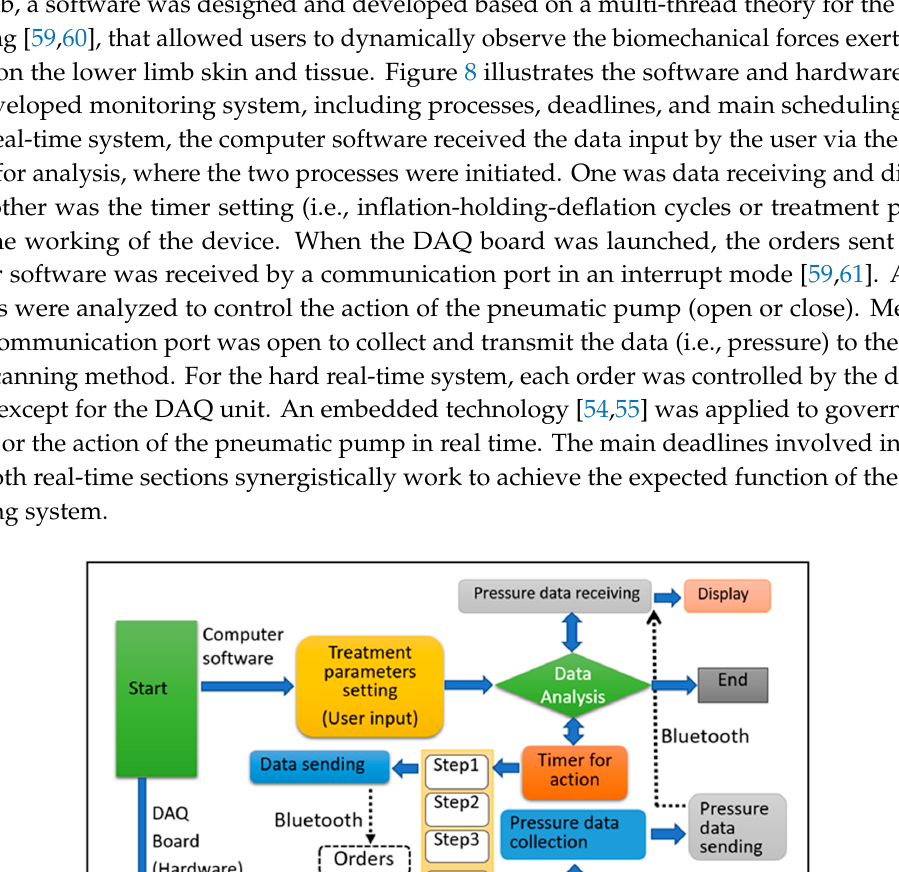
Figure 7. The relationship between the pressure (kPa) and the voltage (V) of the tested sensor cell.